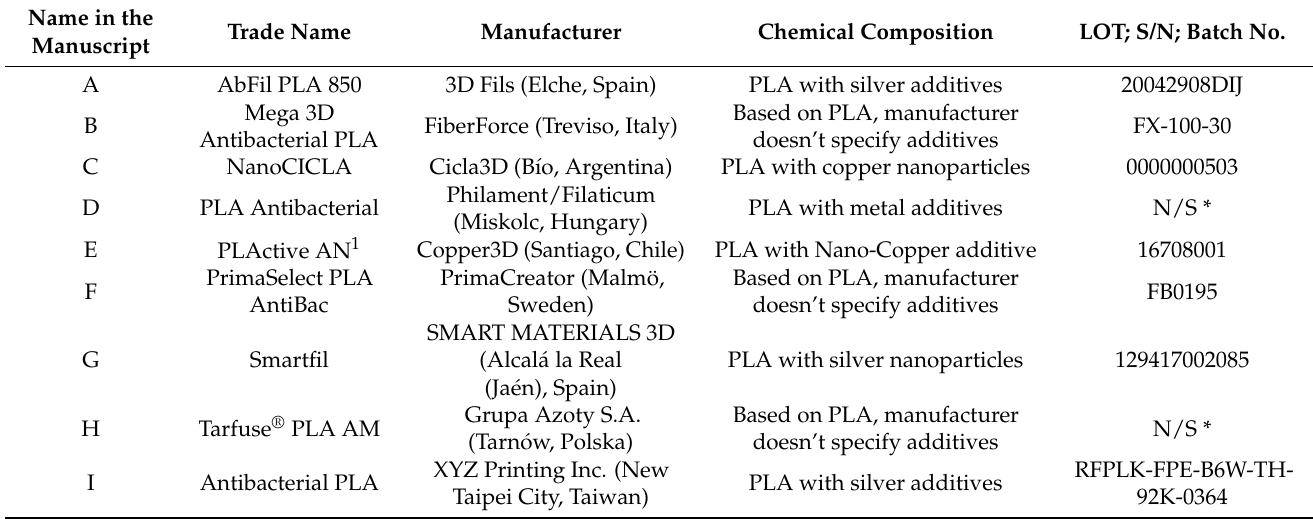
Table 1. The list of filaments with additions.